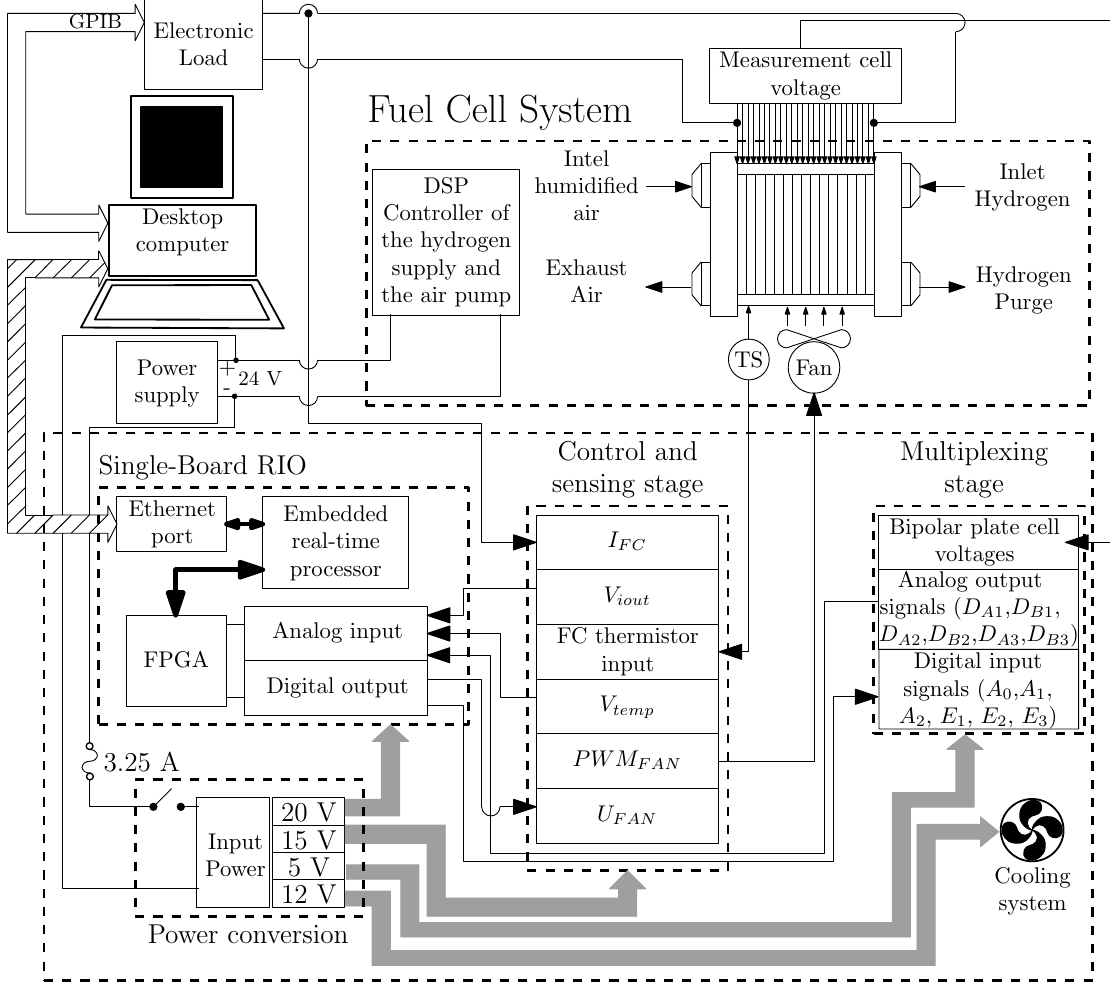
Figure 6. Hardware configuration using to the reactivation of